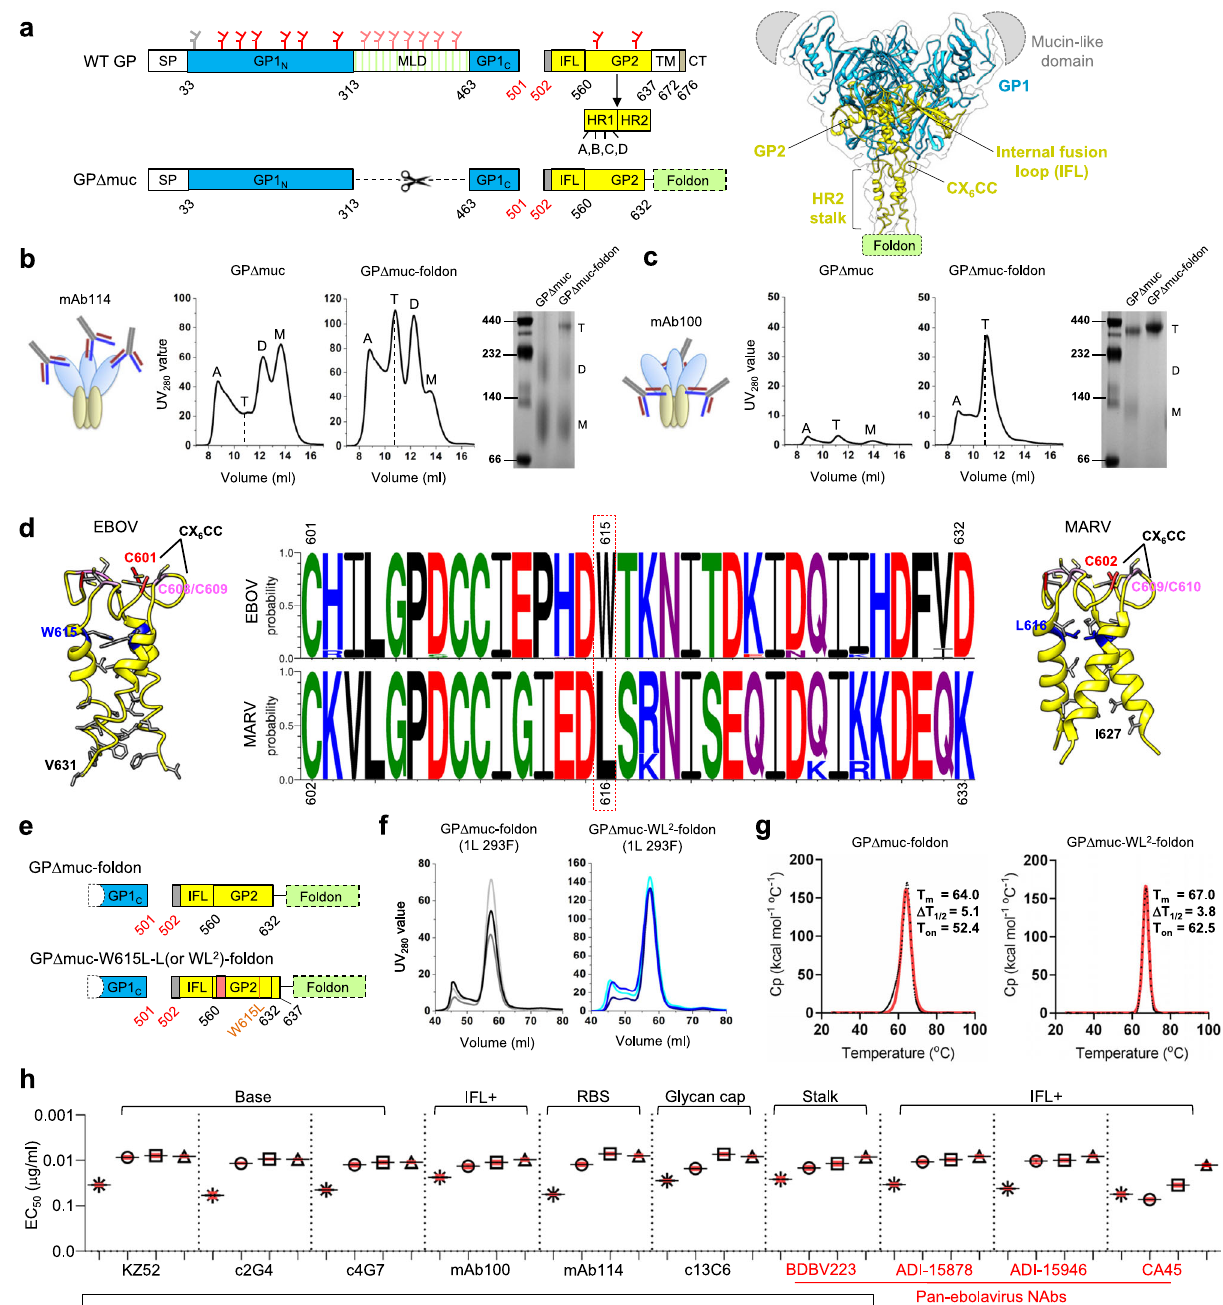
Fig. 1 Design and characterization of EBOV GP Δ muc trimers with modi fi ed HR2 stalk. a Left: Schematic representation of EBOV GP and GP Δ muc. GP1 N/C termini (GP1 N/C ), mucin-like domain (MLD), internal fusion loop (IFL), heptad repeat regions 1/2 (HR1/HR2), transmembrane region (TM), and cytoplasmic tail (CT) are labeled with N -linked glycans, which are indicated as gray (mutated), red, and pink (within MLD) branches. Right: Ribbon representation of EBOV GP (PDB: 5JQ3) in transparent molecular surface, with GP1 in dodger blue and GP2 in yellow. The MLD and foldon are shown as a gray half oval and a green rectangle, respectively. b Schematic representation of mAb114 bound to EBOV GP (left), SEC pro fi les of mAb114-puri fi ed GP Δ muc and GP Δ muc-foldon (middle) from a Superdex 200 10/300 column, and BN-PAGE gel (right). c Schematic representation of mAb100 bound to EBOV GP (left), SEC pro fi les of mAb100-puri fi ed GP Δ muc and GP Δ muc-foldon (middle) from a Superdex 200 10/300 column, and BN-PAGE gel (right). In b , c , GP species (A aggregate, T trimer, D dimer, M monomer) are labeled on the SEC pro fi le and BN-PAGE gel. d Ribbon representation of EBOV HR2 stalk (left) and MARV HR2 stalk (right) with CX 6 CC motif and residues of interest indicated. Middle: Logo analysis of EBOV and MARV HR2 sequences. e Schematic representation of GP Δ muc-W615L-L (or WL 2 )-foldon. f SEC pro fi les of 293F-expressed, mAb100-puri fi ed GP Δ muc-foldon and GP Δ muc-WL 2 -foldon from a HiLoad Superdex 200 16/600 column for three production runs. g Thermostability of GP Δ muc-foldon and GP Δ muc- WL 2 -foldon, with T m , Δ T 1/2 , and T on measured by DSC. h EC 50 ( μ g/ml) values of EBOV GP-foldon, GP Δ muc-foldon, GP Δ muc-W615L-foldon, and GP Δ muc-WL 2 -foldon binding to 10 representative antibodies. Four pan-ebolavirus NAbs are colored in red. Antibody binding was measured by ELISA in duplicates, with mean value and standard deviation (SD) shown as black and red lines, respectively. Source data are provided as a Source Data fi le.